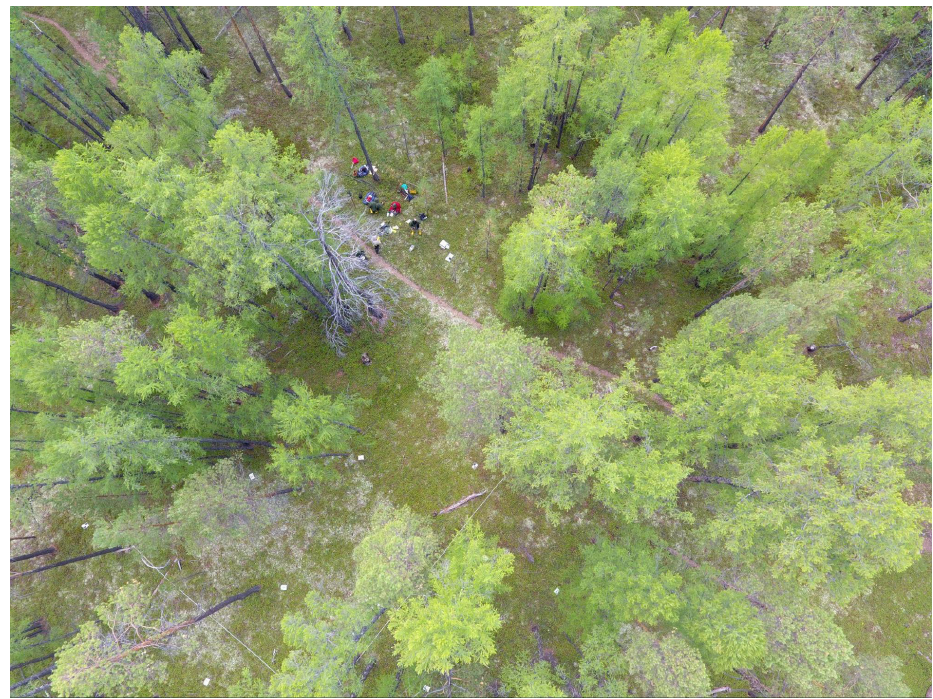
Figure 8. Example of a red–green–blue (RGB) image that was excluded from the 35 images for plot EN18068.